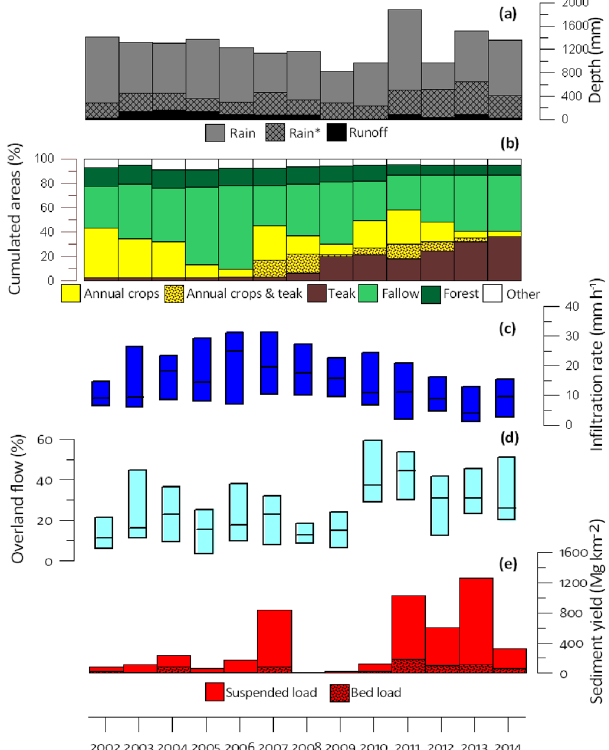
Figure 2. Annual hydro-sedimentary and land-use changes in Houay Pano catchment: ( a ) Total rainfall depth (Rain), flood-triggering rainfall depth (Rain_F) and total stream flow depth (Runoff); ( b ) Areal percentages of the catchment covered by the main land uses (i.e. annual crops; annual crops associated with one-or-two-years- old teak trees; teak plantations; fallow; secondary forest and other land uses including gardens and banana); ( c ) Box plots (25 th and 75 th percentiles and median) of infiltration rates computed for each flood event; ( d ) Box plots of overland flow contribution to total depth of flood events estimated using tracer-based hydrograph separation; ( e ) Annual sediment yield including suspended load and bed load contributions. This graph was created using Grapher 4.0 from Golden Software,